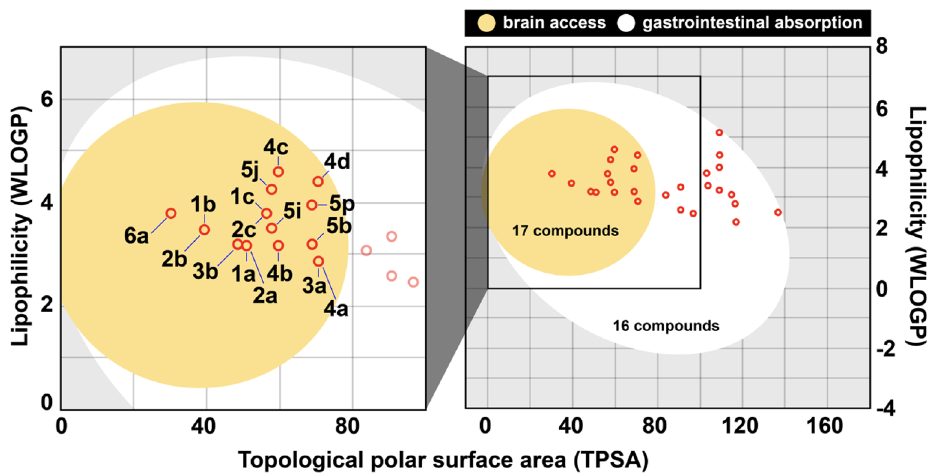
Figure 8. The passive gastrointestinal absorption (egg white area) and brain access across the blood–brain barrier (yolk area) prediction for 33 flavone analogs were plotted as a BOILED-Egg model.